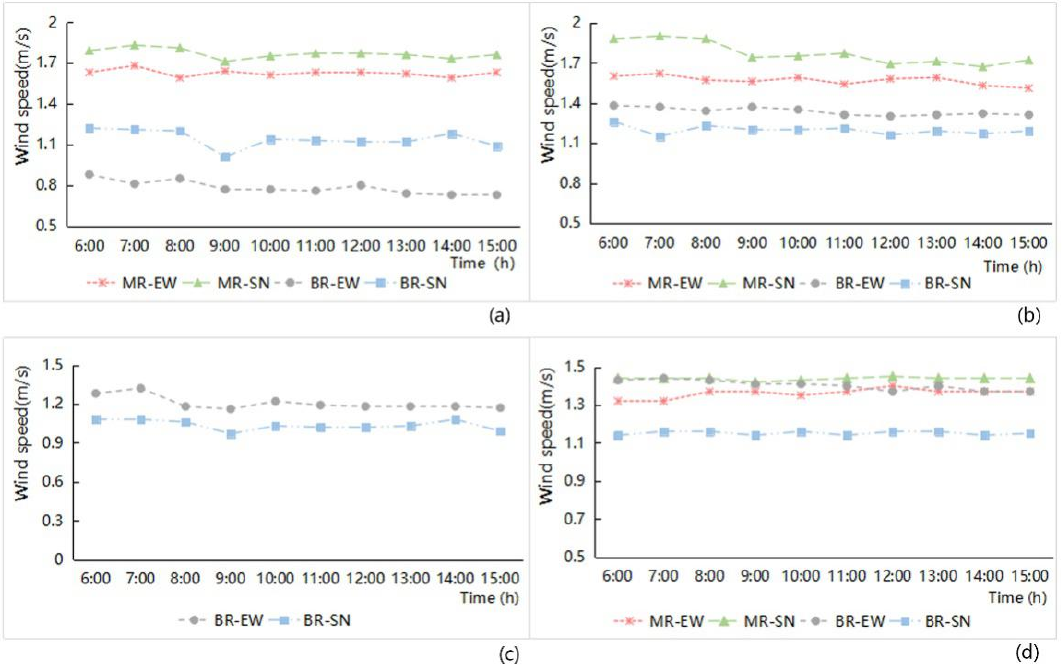
Figure 8. Hourly wind speed variation analysis related to the different grade width and orientation of street space from 6:00 to 15:00 in the four study areas (( a ) Old downtown; ( b ) Gubei international community; ( c ) Anting New Town; ( d ) New Jiangwan Town).